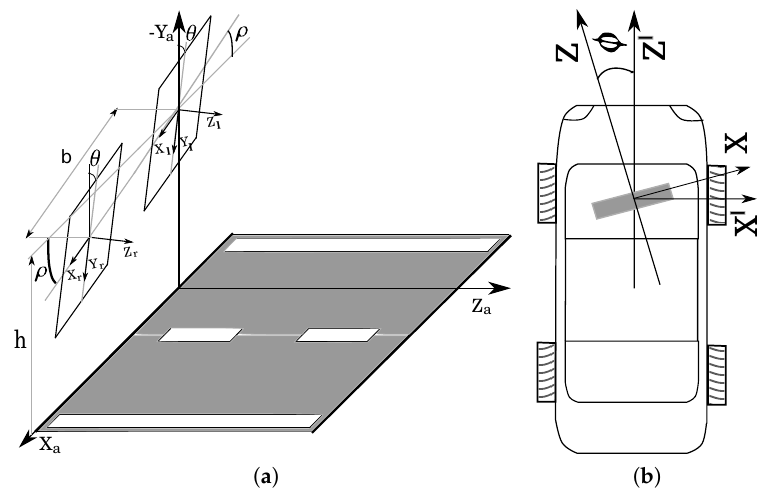
Figure 1. ( a ) Schema of the configuration of the stereo rig in relation to the ground; ( b ) schema of the yaw deviation ( φ